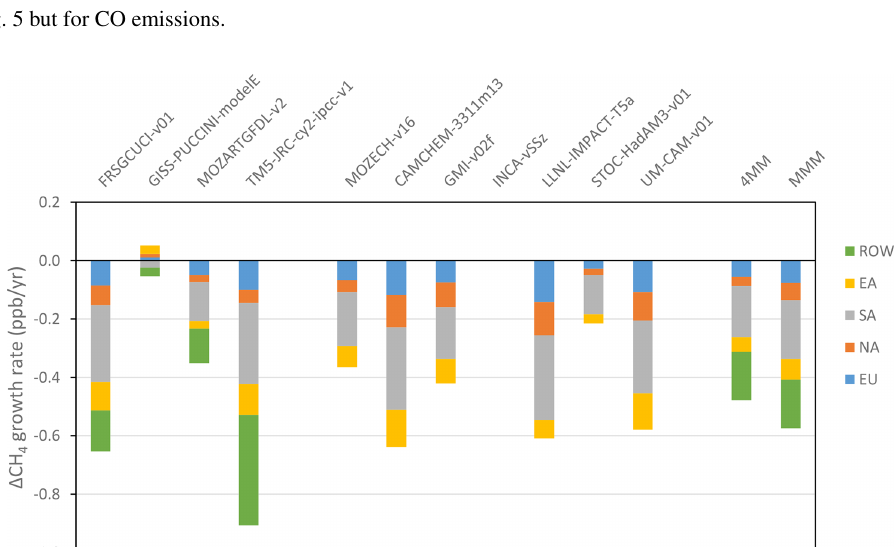
Figure 7. As in Fig. 5 but for NMVOC